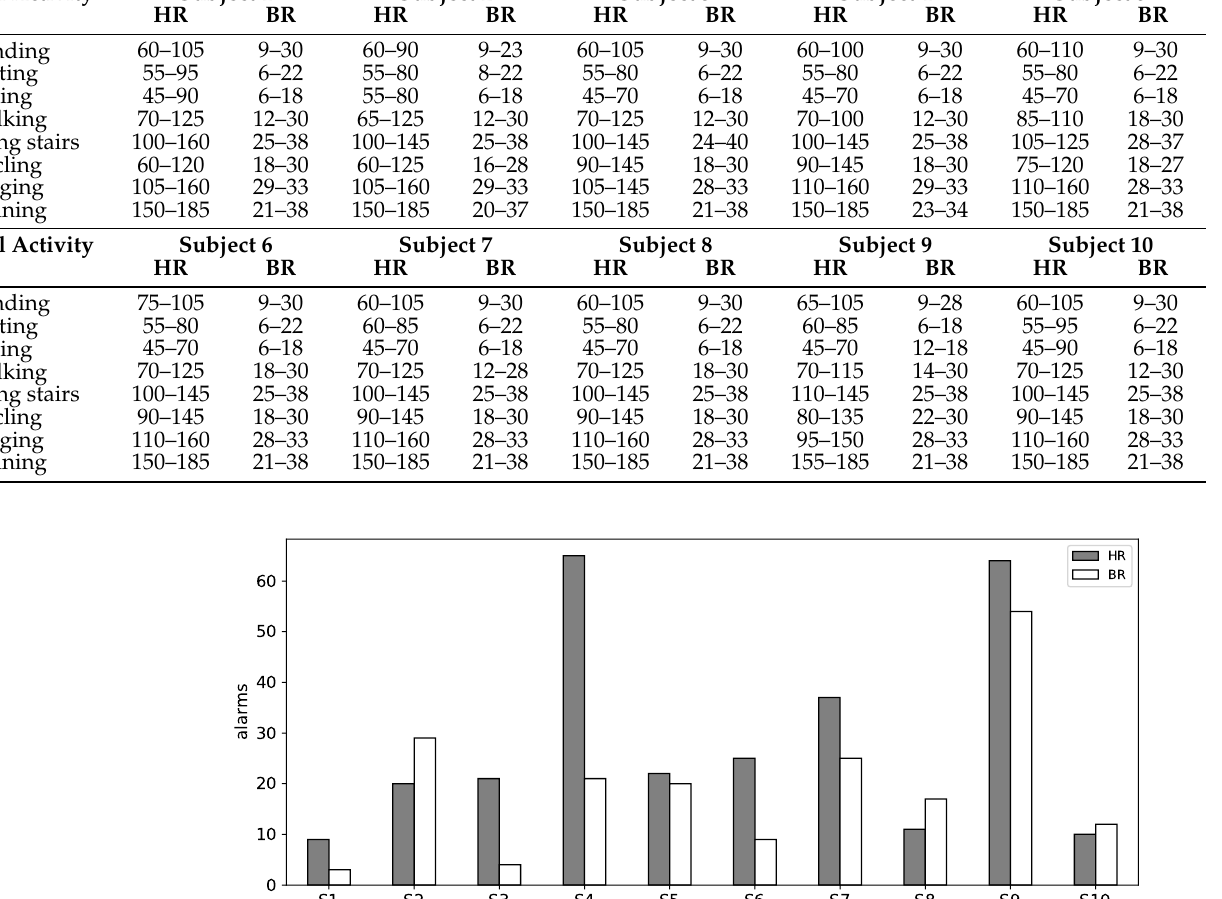
Figure 15. Warnings/alerts generated when physiological measurements exceeded the normal